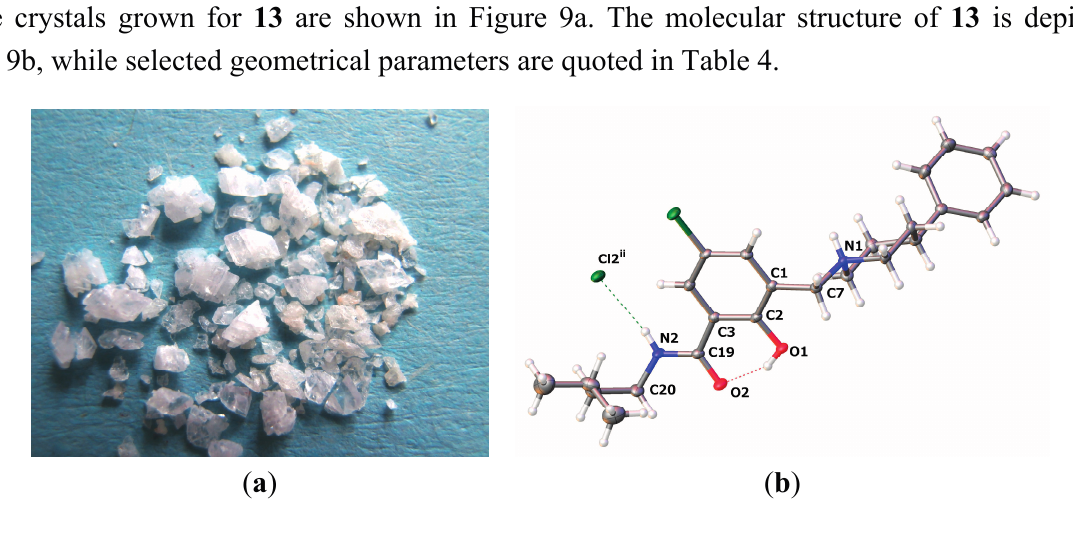
Figure 9. ( a ) Crystals grown for 13 ; ( b ) molecular structure of 13 (drawn at a 50% probability level; dashed lines: hydrogen